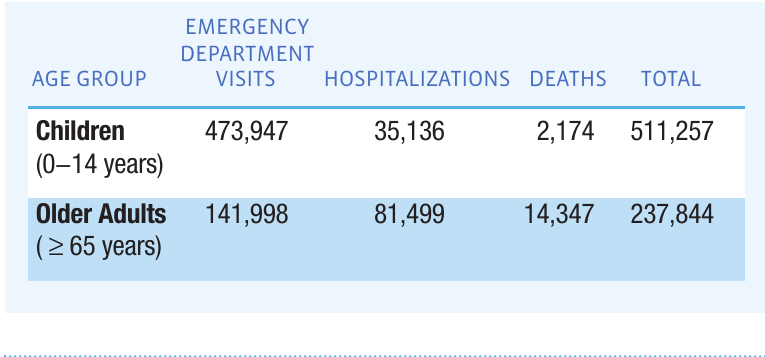
FIGURE 2: Estimated Average Annual Rates of Traumatic Brain Injury-Related Emergency Department Visits, Hospitalizations, and Deaths, by Age Group, United States,